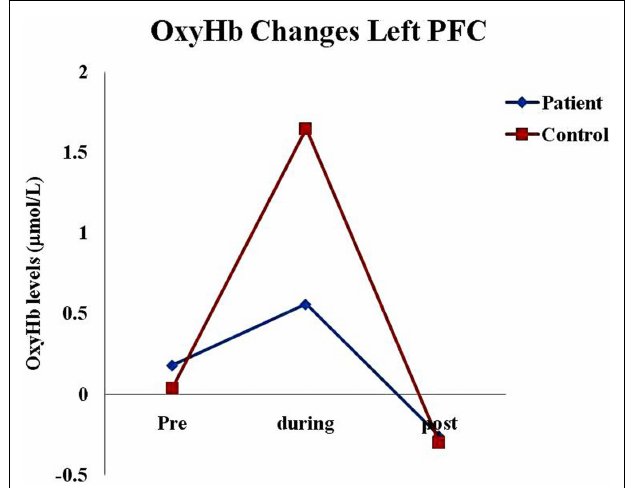
FIGURE 1 | Oxygenated hemoglobin changes in healthy subjects and schizophrenia patients in left pre-frontal cortex before (pre), during, and after (post) KB practices . Abbreviations: oxyHb, oxygenated hemoglobin; deoxyHb, deoxygenated hemoglobin; totalHb, total hemoglobin; PFC, pre-frontal cortex.